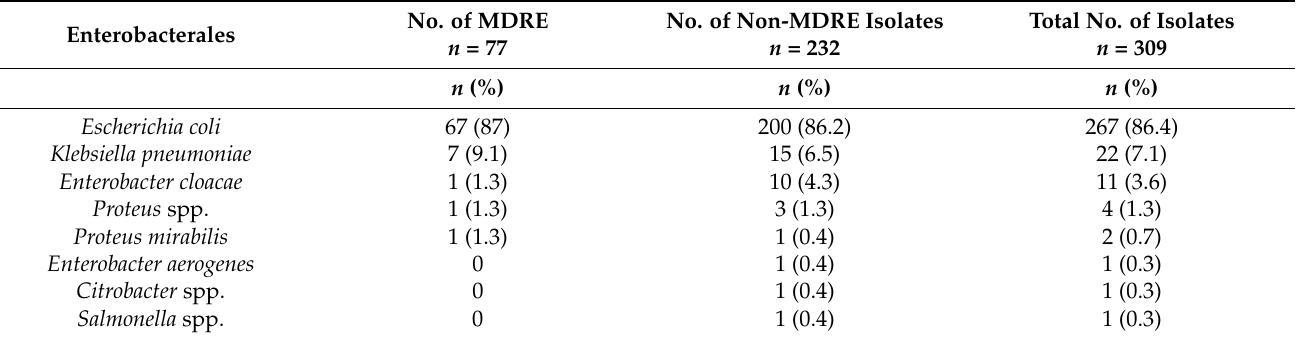
Table 2. Distribution of Enterobacterales with and without multidrug-resistant phenotypes.